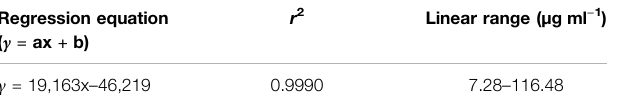
TABLE 6 | Calibration curve for the analysis of the asperulosidic acid.